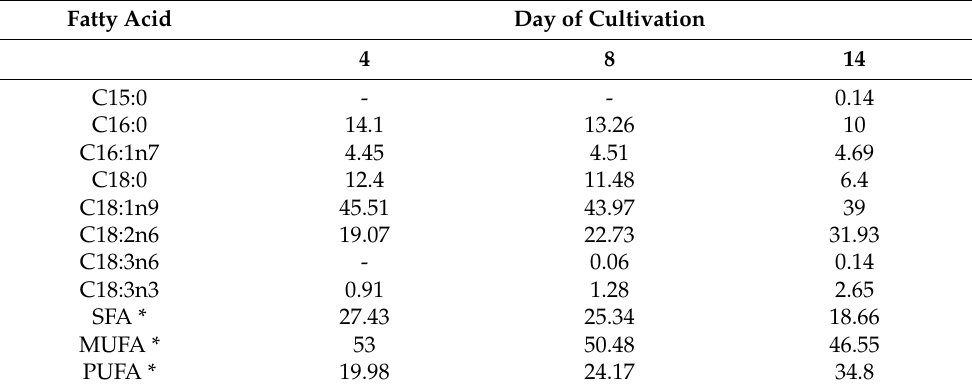
Table 1. Monitoring changes of fatty acids during cultivation in selected strain by gas chromatography (GC). Fatty acid profile (%) of lipid content produced by Metschnikowia pulcherrima 149 with C/N ratio 97. Fatty Acid Day of Cultivation 4 8